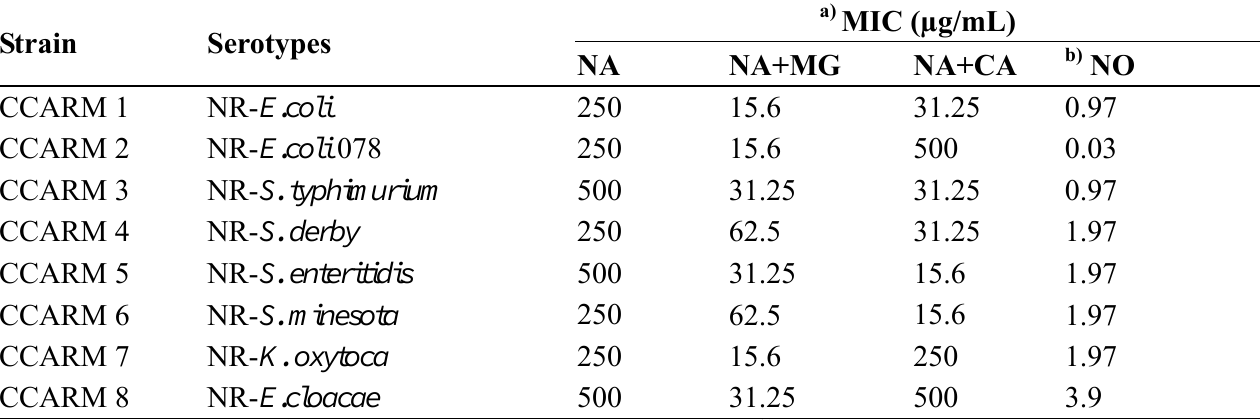
Table 3. Antibacterial activity of nalidixic acid (NA), nalidixic acid (NA) + methyl gallate (MG), nalidixic acid (NA) + carvacrol (CA), and norfloxacin (NO) against nalidixic acid- resistant pathogenic bacteria (NR).